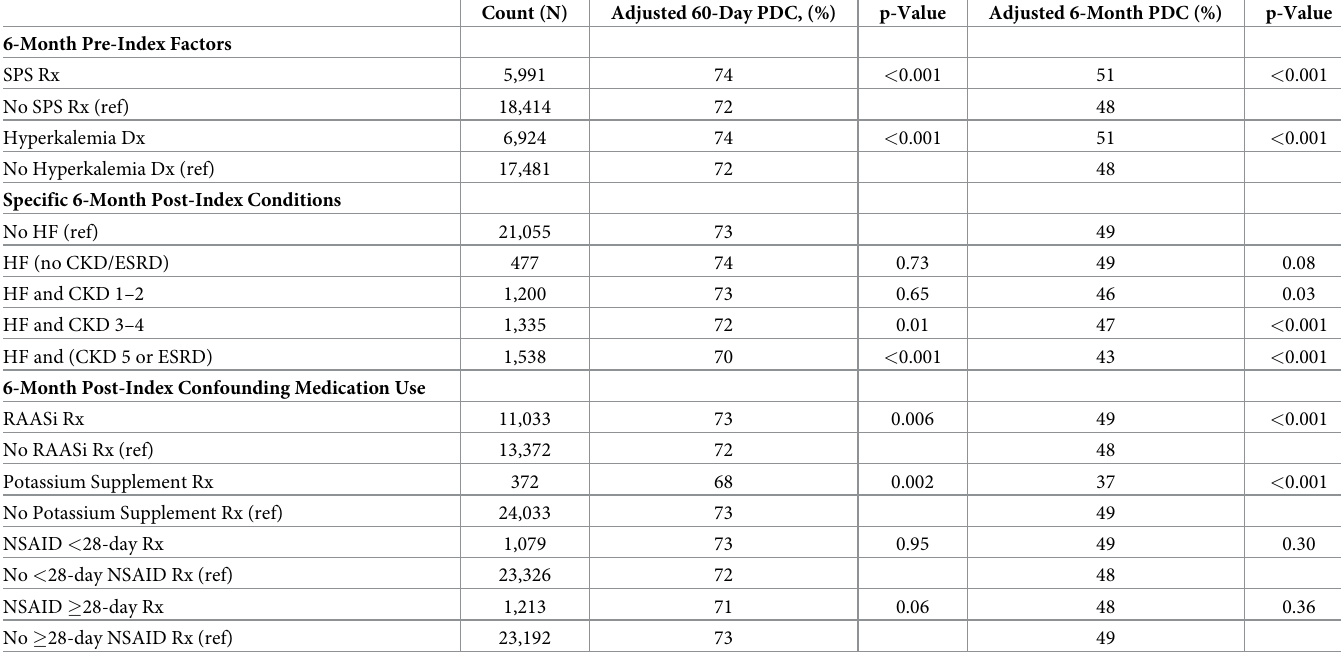
Table 3. Concurrent confounding conditions in adherence study population.